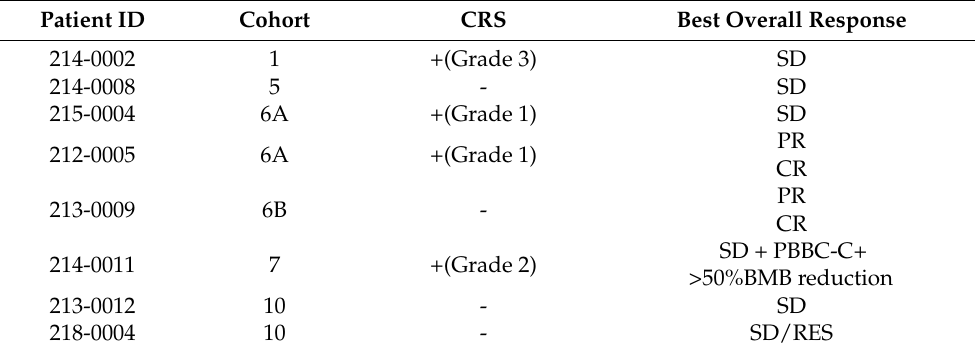
Table 3. CRS history of APVO436-treated R/R AML patients with favorable responses.